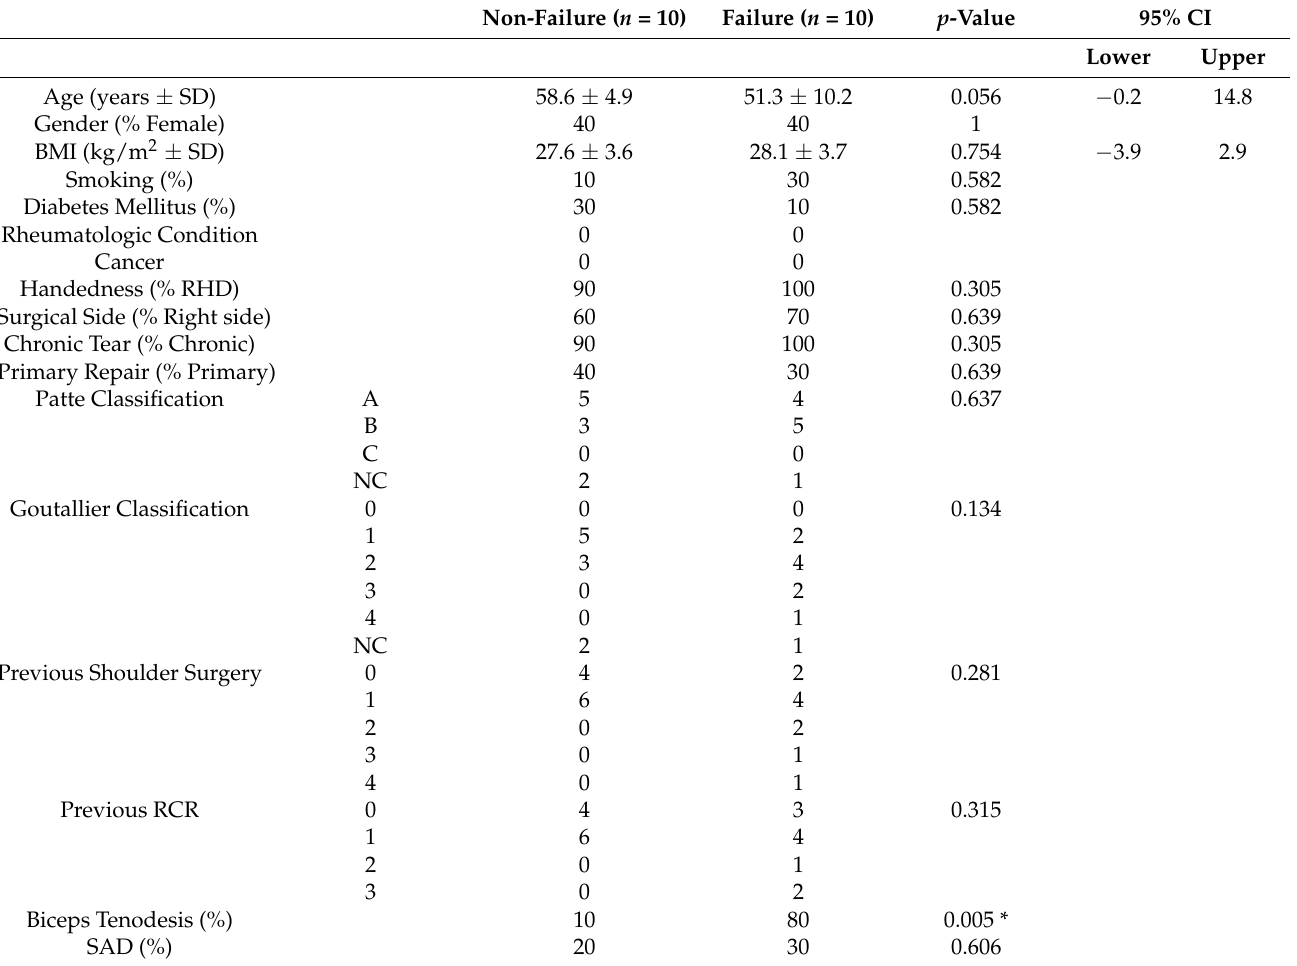
Table 1. Demographic and Injury Information for Non-Failure and Failure